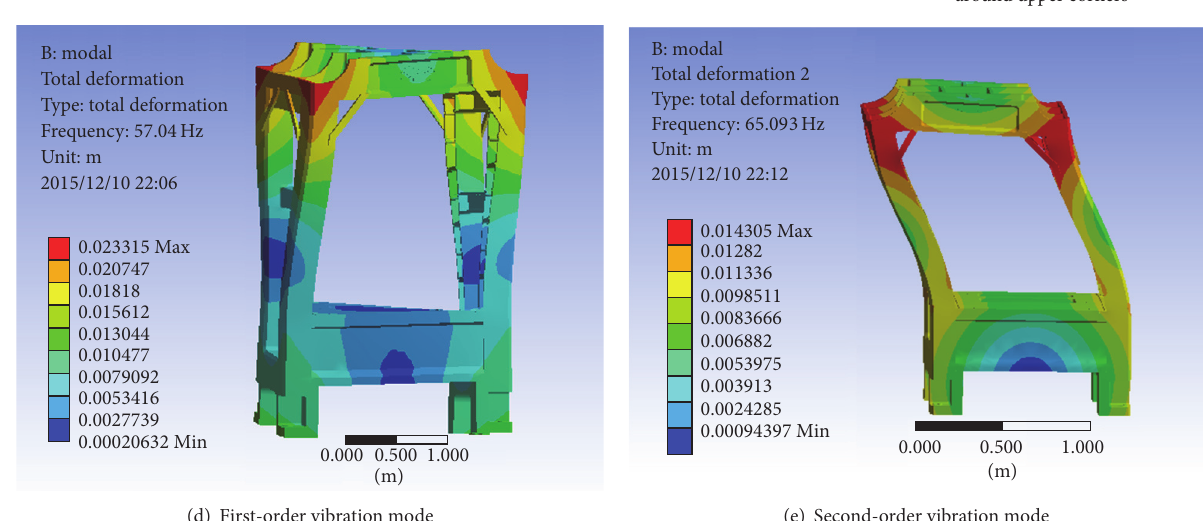
Figure 16: Structural modification and related results for the first two orders of vibration of the